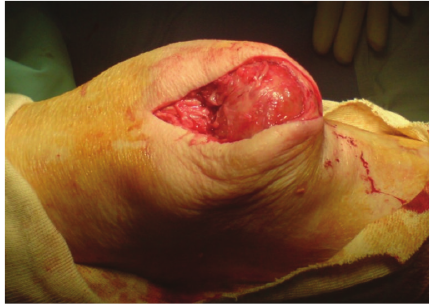
Figure 3: Intraoperative picture with patella dislocated.